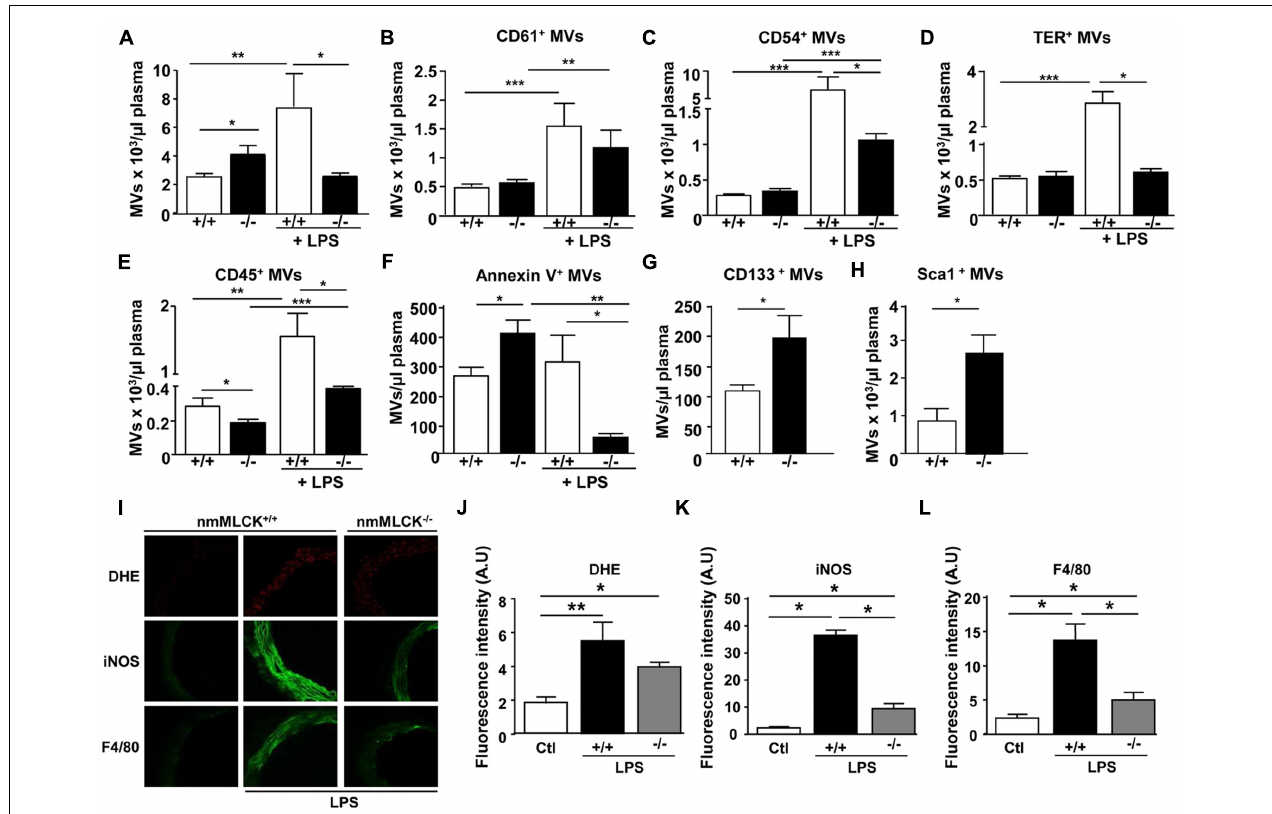
FIGURE 1 | Deletion of non-muscular myosin light chain kinase (nmMLCK) prevents changes on MV levels induced by LPS. Circulating MVs collected from blood were incubated with antibodies to discriminate MV subpopulations according to the expression of membrane specific antigens by flow cytometer. Histograms show total circulating MVs (A) , platelet-(CD61 + ) (B) , endothelial cell- (CD54 + ) (C) , erythrocyte-(TER + ) (D) , leukocyte-(CD45 + ) (E) , procoagulant-(annexin V + ) (F) , and progenitor cell- (CD133 + , Sca1 + ) (G,H) MVs from nmMLCK + / + and nmMLCK − / − mice treated intraperitoneally or not with LPS (40 mg/kg) for 4 h. Values are expressed as events per microliters and the data represent the mean ± SEM ( n = 16–21) ∗ P < 0.05, ∗∗ P < 0.01, ∗∗∗ P < 0.001. (I) Confocal image staining of superoxide anion production by DHE (red), iNOS (green), and macrophage infiltration (F4/80 green) in thoracic aorta from nmMLCK + / + and nmMLCK − / − mice injected intraperitoneally by LPS (40 mg/kg) for 4 h. Histograms show fluorescence intensity of aorta DHE staining (J) , iNOS (K) , and F4/80 (L) , assessed by Image J. Data are expressed in arbitrary units (A.U.) of fluorescence intensity and represent the mean ± SEM ( n = 3–5) ∗ P < 0.05, ∗∗ P <